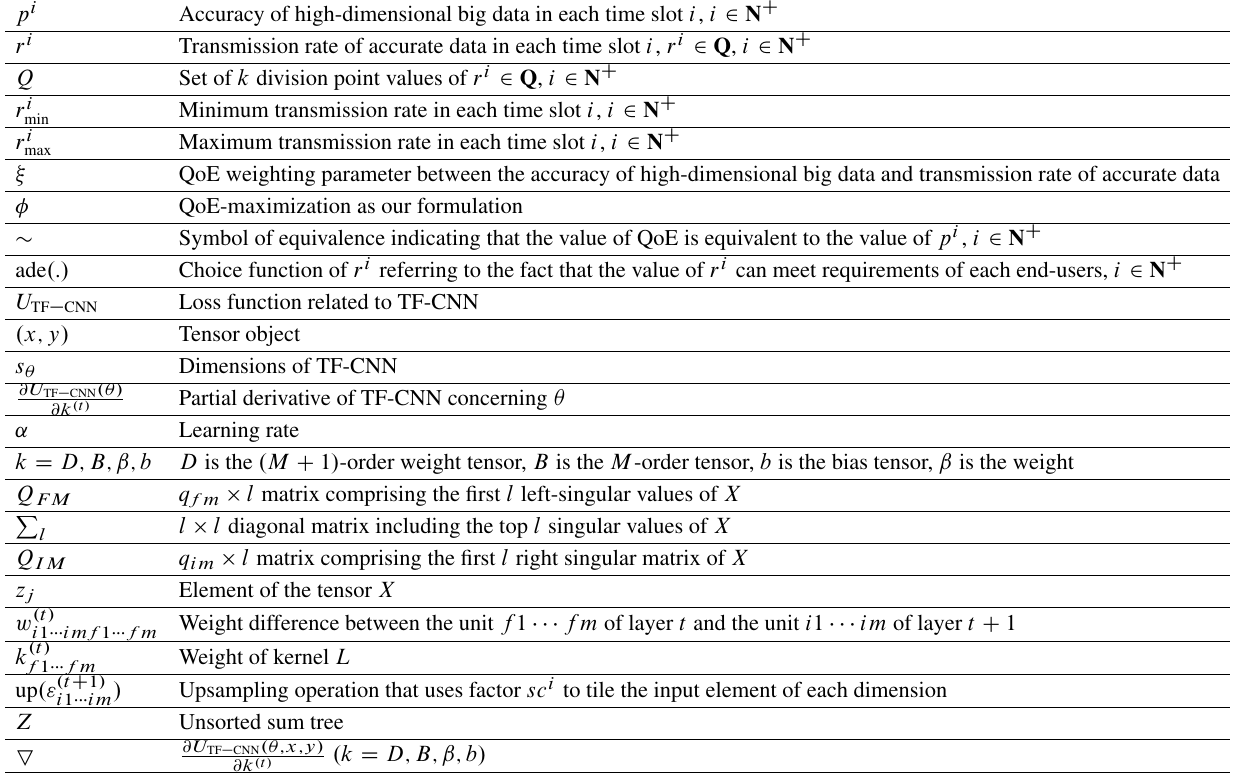
Table 1 Important